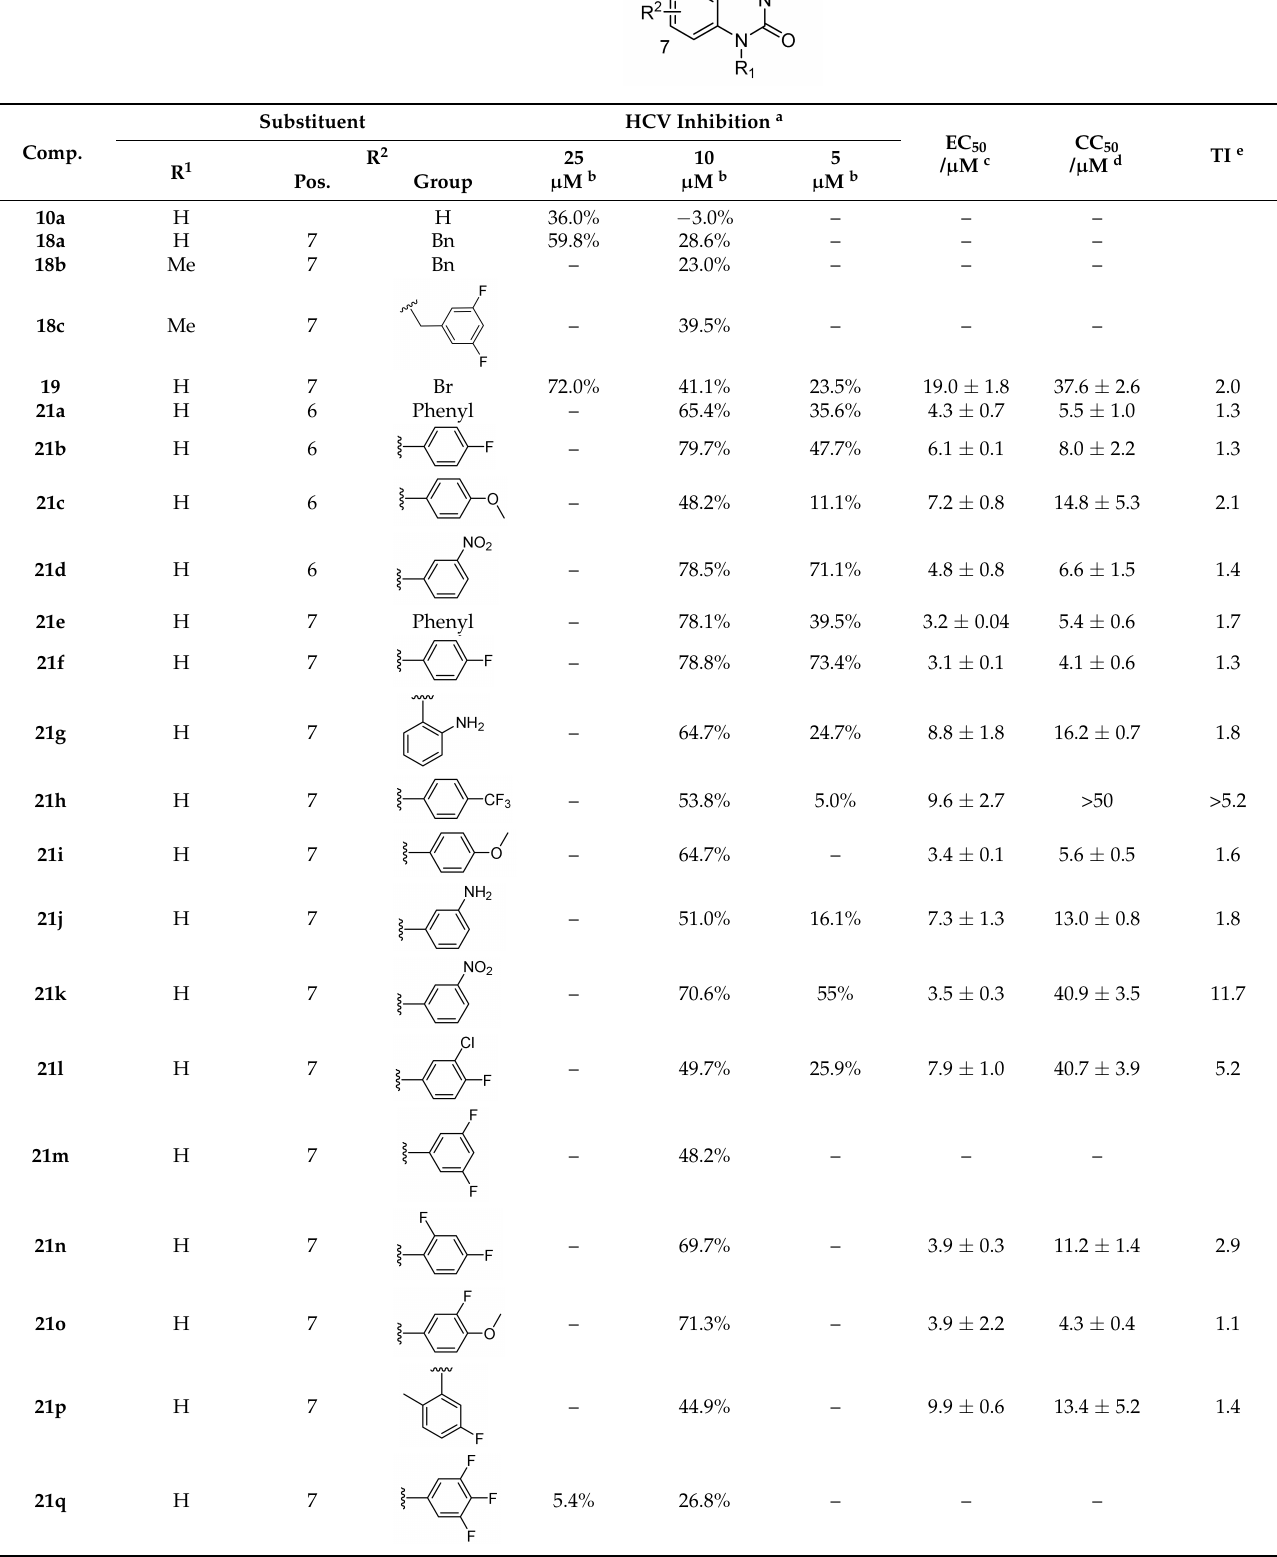
Table 2. Anti-HCV assay of C-6/C-7/C-8 substituted 3-hydroxy-quinazoline-2,4(1 H ,3 H